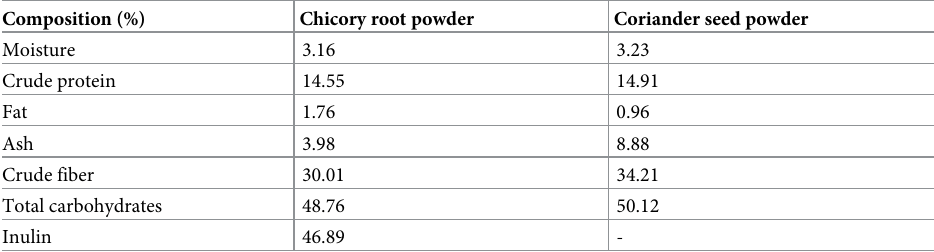
Table 3. Chemical composition of Chicory root